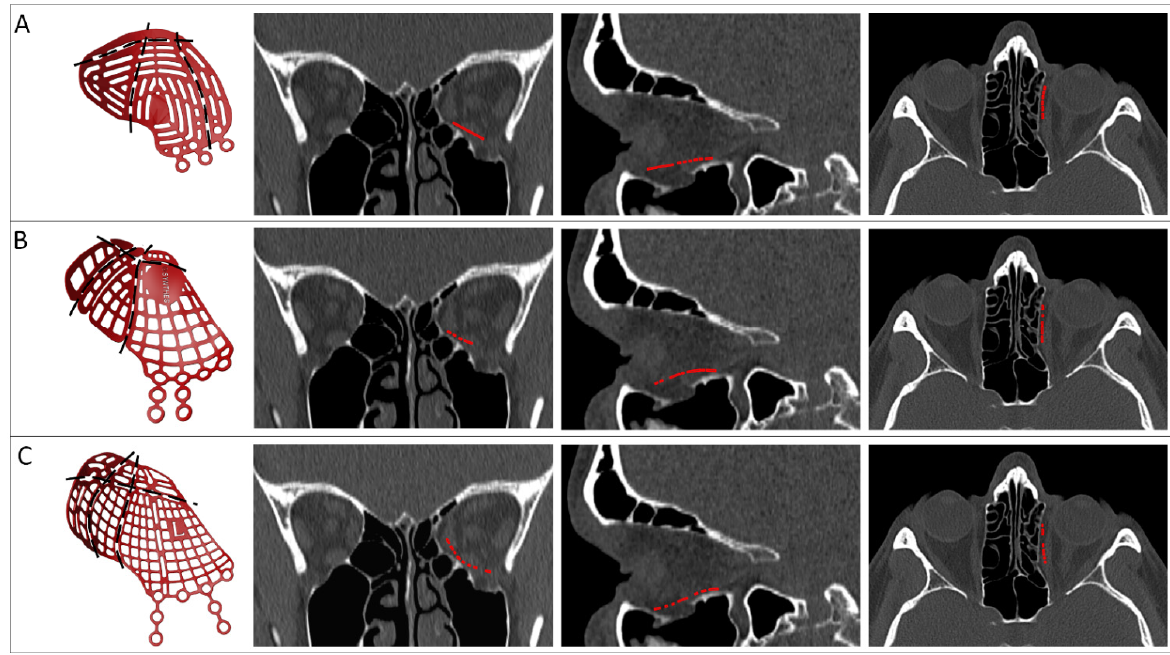
Figure 3. Virtual fitting of different preformed implants in a solitary orbital fracture. Three-dimensional models of the preformed implants of KLS Martin ( A ), Synthes ( B ) and Stryker ( C ) are visualized with potential cutting lines (black lines) in the first column. The implants are virtually positioned (red contour) and the fit is evaluated in the coronal, sagittal, and axial slices. Important considerations are adequate support (on the posterior ledge, on the medial wall and on the infraorbital rim) and a lack of interference with bone .